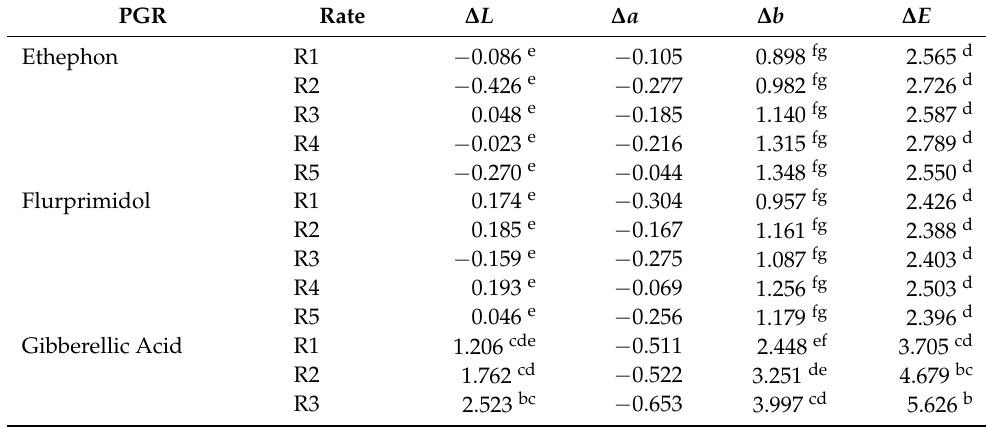
Table 3. The ∆ L , ∆ a , ∆ b , and ∆ E color parameters of Kentucky bluegrass leaves after PGR